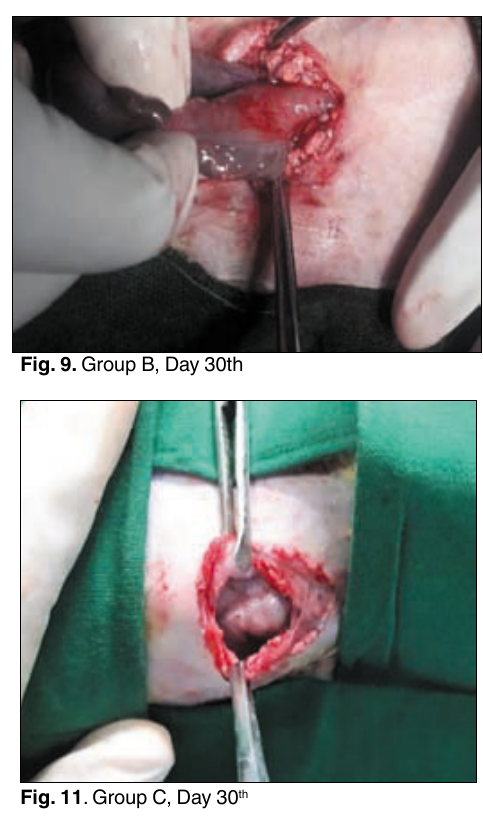
Fig. 10 . Group C, Day 10 th Fig. 11 . Group C, Day 30 th